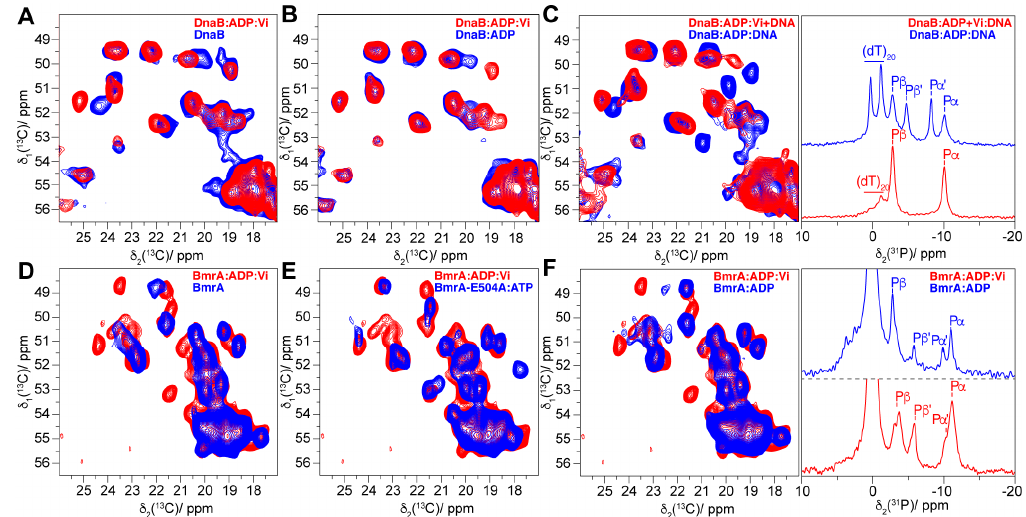
Figure 6. Comparison of the effect of vanadate on BmrA and DnaB. Alanine region from 13 C- 13 C- DARR spectra of DnaB:ADP:Vi overlaid with DnaB apo ( A ), DnaB:ADP ( B ). Alanine region from 13 C- 13 C-DARR ( C , left panel) and 1D 31 P-CP ( C , right panel) spectra of DnaB:ADP:Vi;DNA overlaid with DnaB:ADP:DNA. Alanine region from 13 C- 13 C-DARR spectra of BmrA:ADP:Vi overlaid with BmrA apo ( D ), BmrA-E504A:ATP ( E ) and BmrA:ADP (left panel) complemented with the 1D 31 P spectrum ( F ,rightpanel). Theresonancepeakfromthelipids(0ppm)wascut, theseparationbetweenthetwospectra is indicated by a dashed line. The blue spectrum in ( A ) was adapted from Wiegand et al. 2019 and spectra ( D ) and ( E ) were adapted from Lacabanne et al. 2019 [82,92] (http: // creativecommons.org / licenses / by / 4.0 / .). The red spectra in ( A ) and ( C ), as well as the spectra in ( F ) are original